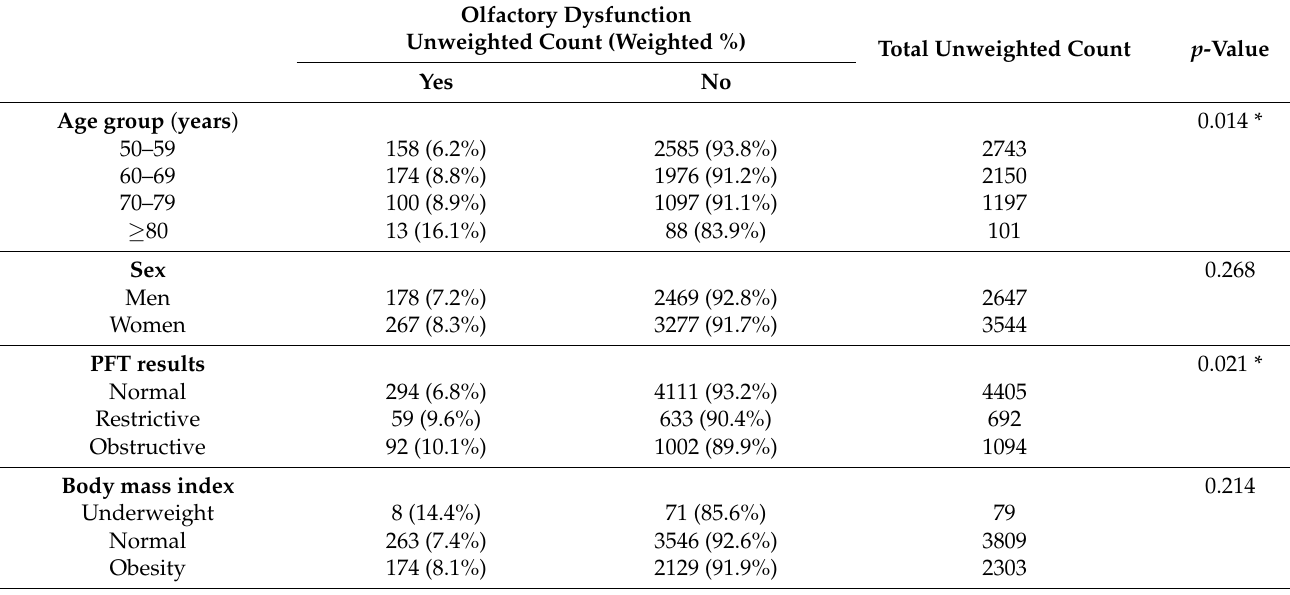
Table 1. Prevalence of olfactory dysfunction according to participant